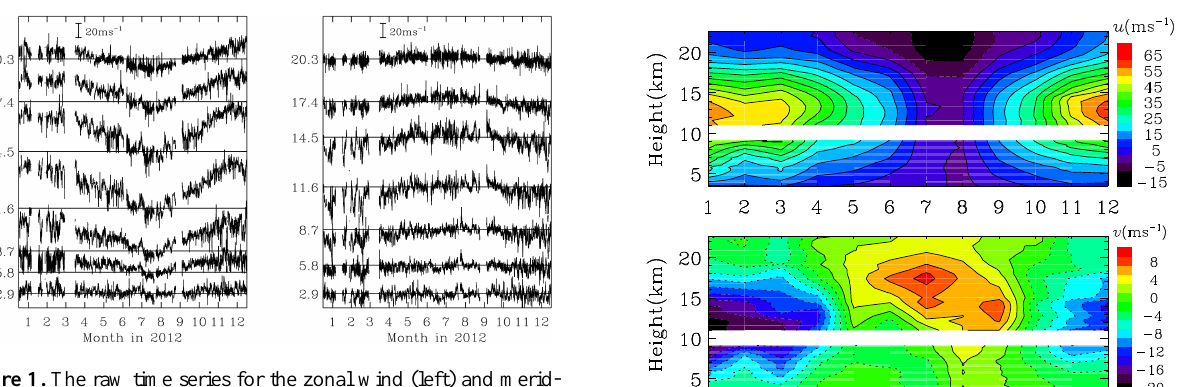
Figure 1. The raw time series for the zonal wind (left) and merid- ional wind (right) at every 2.9km in the whole year of 2012. The horizontal lines denote the zero values.